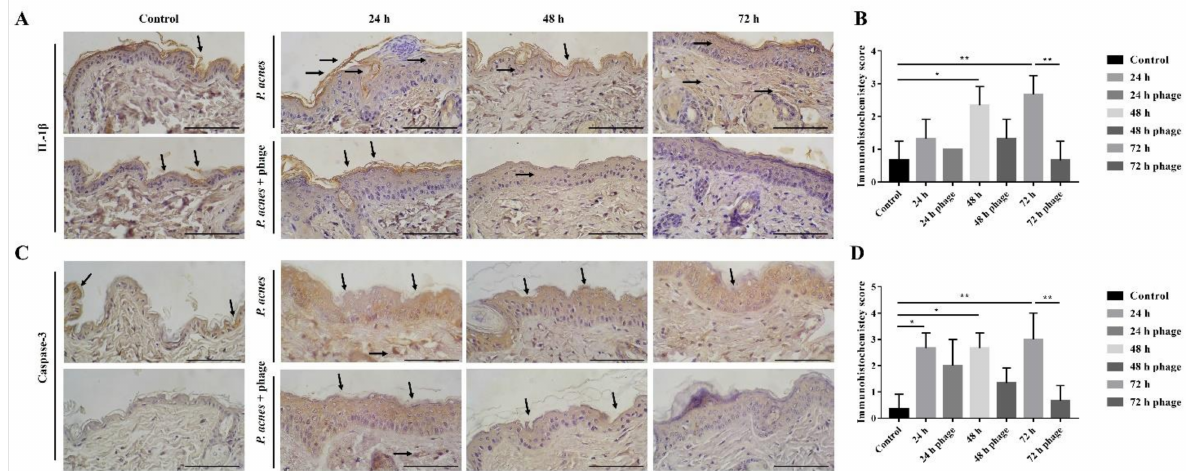
Figure 4. ( A ) Representative images showing IL-1 β staining. ( B ) Immunohistochemistry score performed based on staining incidence of IL-1 β . ( C ) Representative images showing Caspase-3 staining. ( D ) Immunohistochemistry score performed based on staining incidence of Caspase-3. Arrows show positively stained areas. Results are expressed as the mean ± standard deviation ( n = 3). * p < 0.05; ** p < 0.01. Significance according to one-way ANOVA with post hoc tests, performed using GraphPrism 6.01 software.